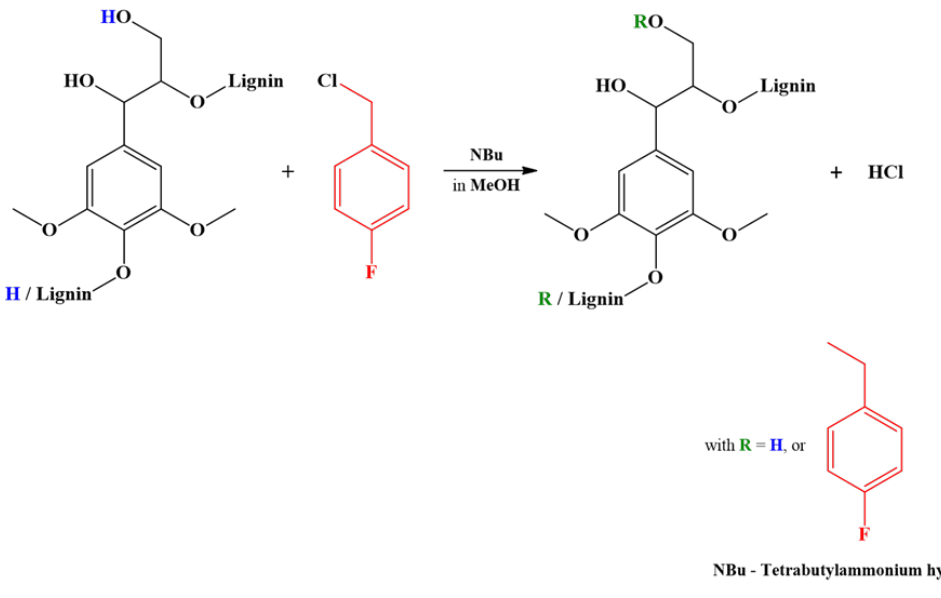
Figure 3. Reaction of lignin fluorobenzylation.